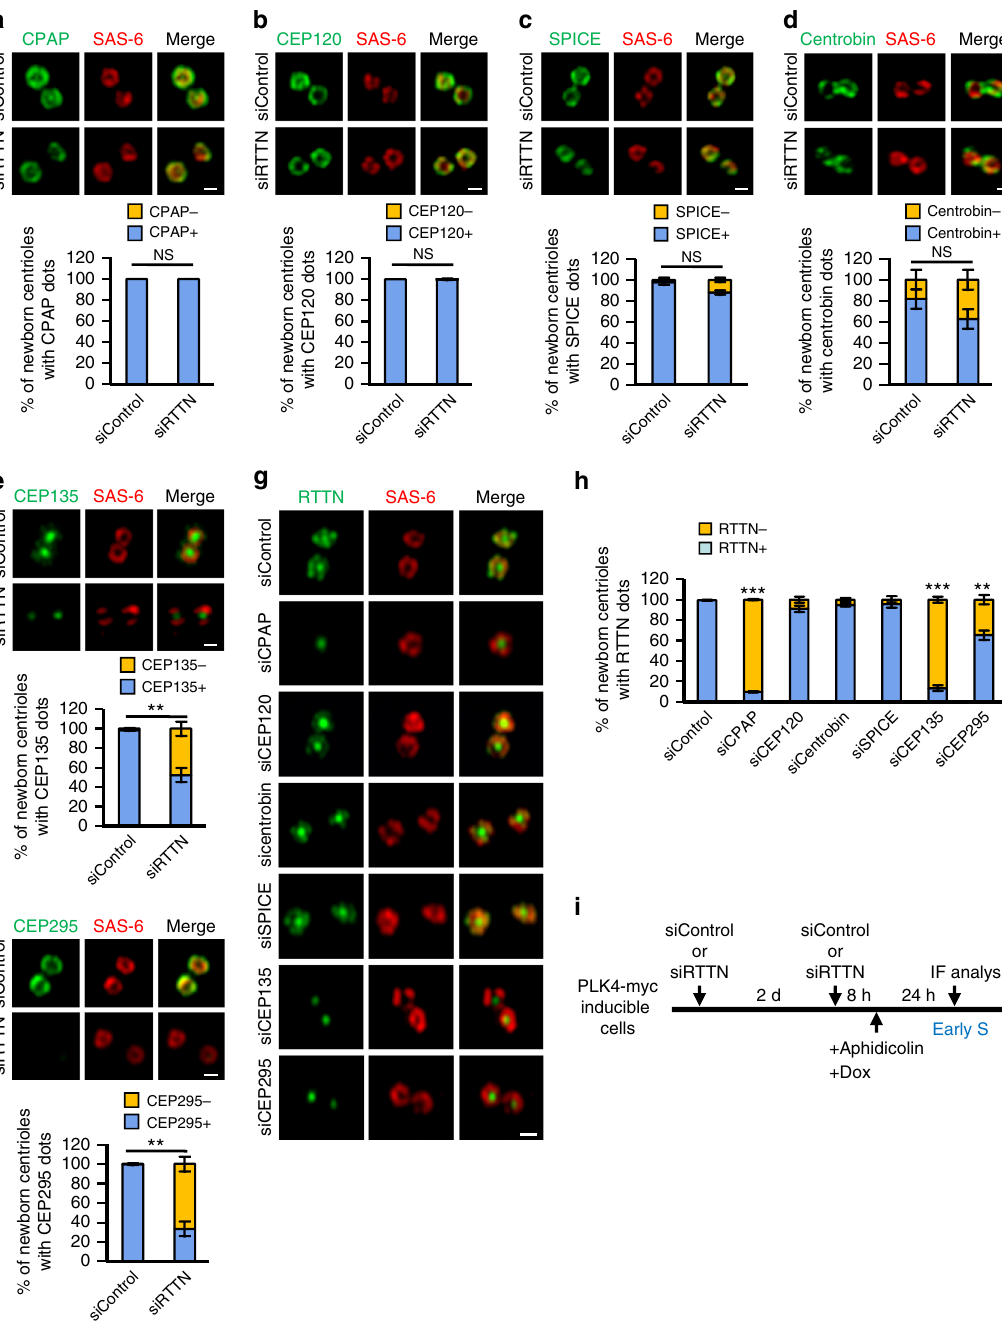
NATURE COMMUNICATIONS | 8: